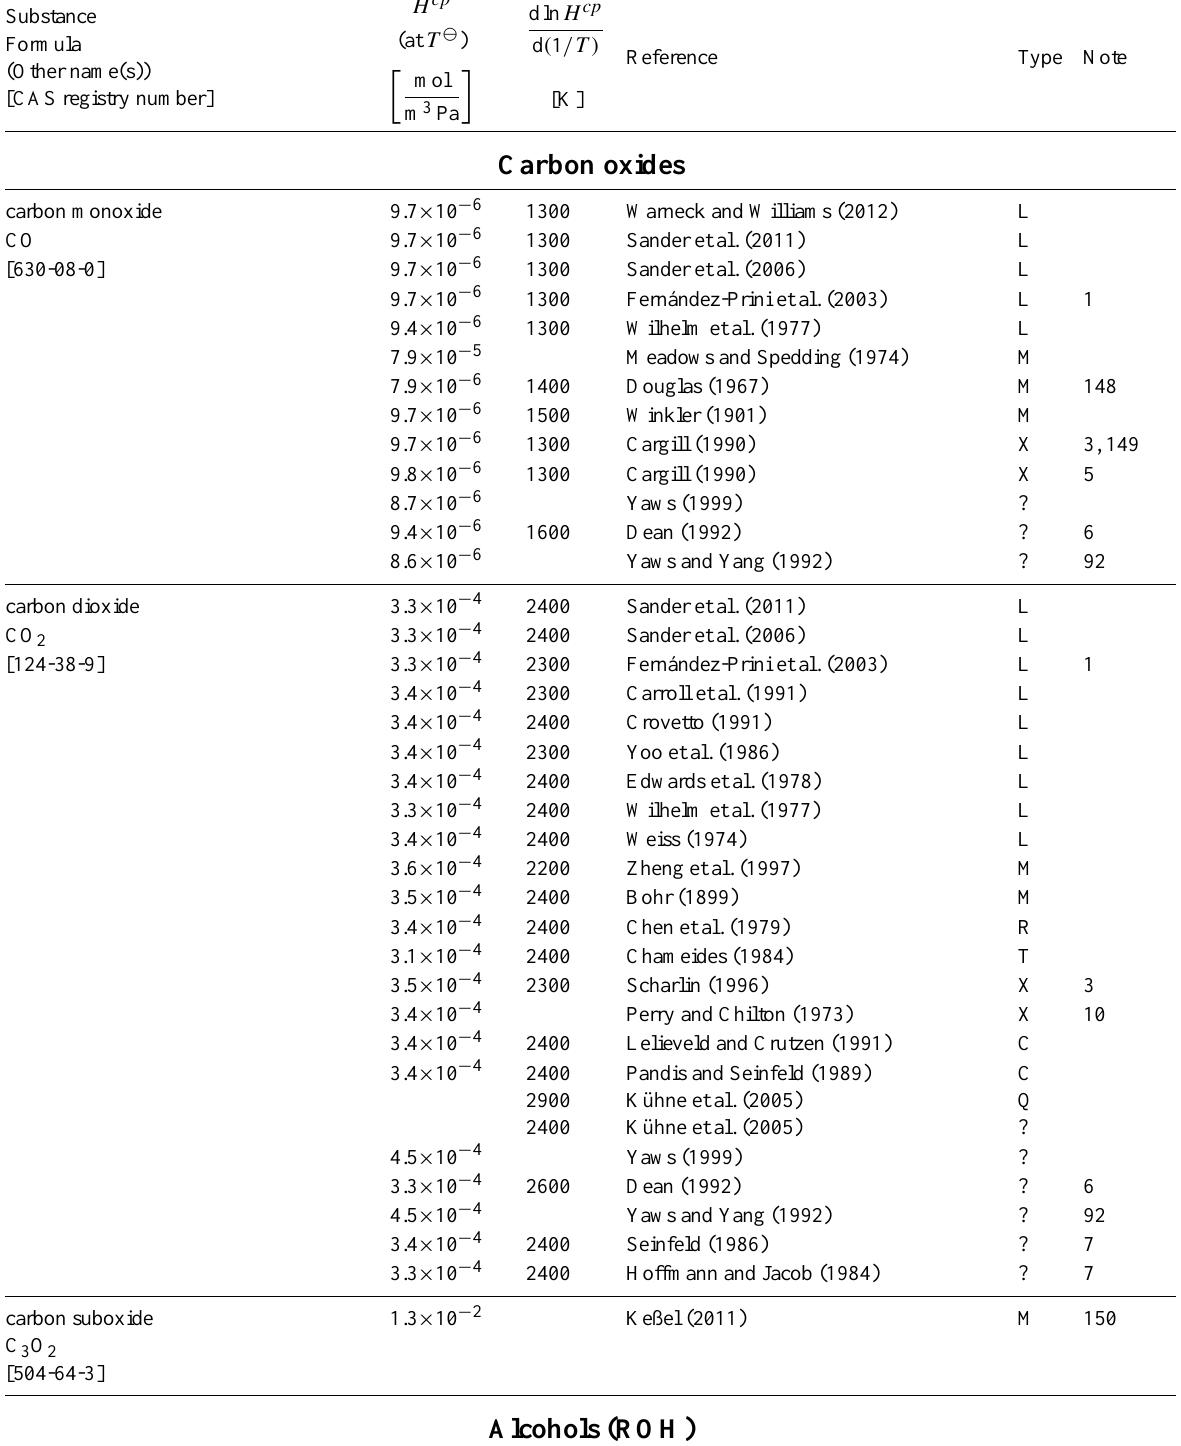
Table 6: Henry’s law constants for water as solvent